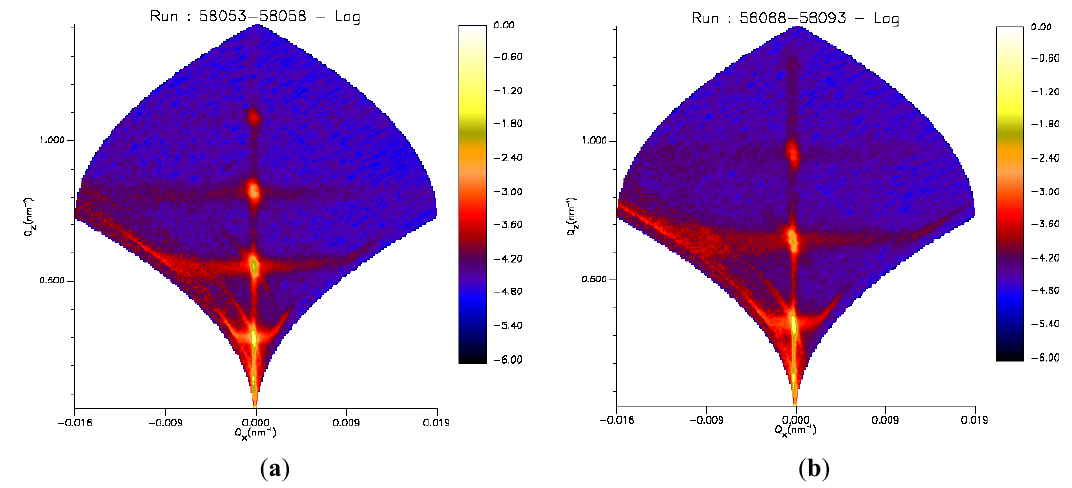
Figure 5. Neutron scattering maps of sample B at the solid–liquid interface incubated with PAH-15 in D 2 O at 20 °C ( a ) and 38 °C ( b ) with specular Bragg peaks up to fourth order on the Q z axis at Q x = 0, i.e ., perpendicular to the interface. Diffuse bands of scattered intensity (Bragg sheets) intercepting the Bragg peaks and extending to finite Q x at constant Q z , i.e ., parallel to the interface, are also